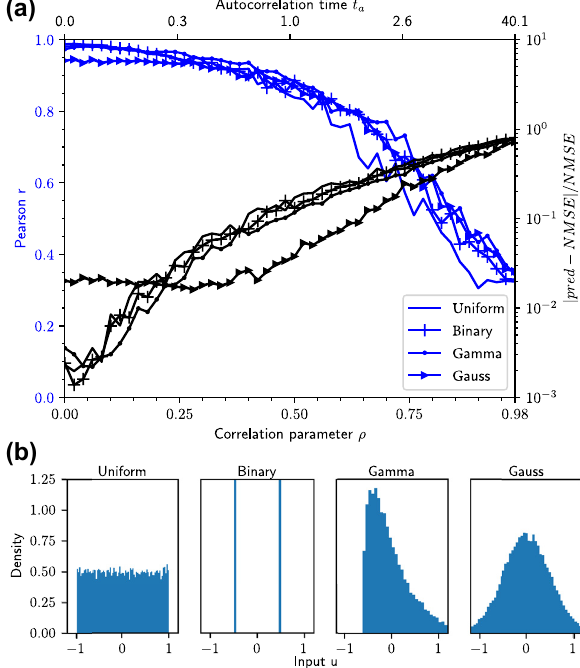
Figure 5: Impact of correlated inputs for performance predictions: (a) Blue lines: Pearson correlation coefficient r between predicted and measured NMSE as a function of the input correlation parameter (see Eq. (16)) for four different random distributions p ( 𝜒 ) (different line styles). r is determined from a scan over 50 distinct delay times 𝜏 ϵ [20 , 1600] in the setup corresponding to Figure 2b. Black lines: Mean square error between predicted and measured NMSE. (b) Histograms of uniform, binary, gamma and Gaussian distribution chosen in (a).